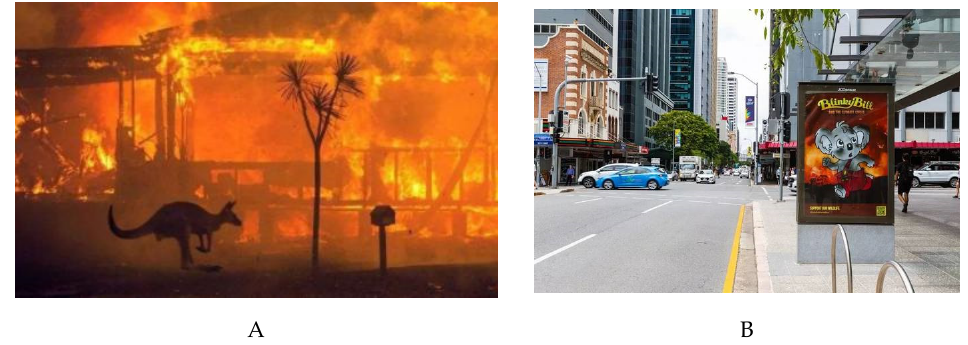
Figure 8. Screenshots of two ways of media reporting—taking the 2019–2020 fire season in eastern Australia as an example. The method shown in Screenshot ( A ) is a common way to report, in which the bushfire in Australia occupied the whole image area. However, Screenshot ( B ) utilizes a picture-in-picture technology that the proportion of the focus event in the whole picture has been adjusted; the warning sign about the Australian bushfire is displayed together with the surrounding peaceful